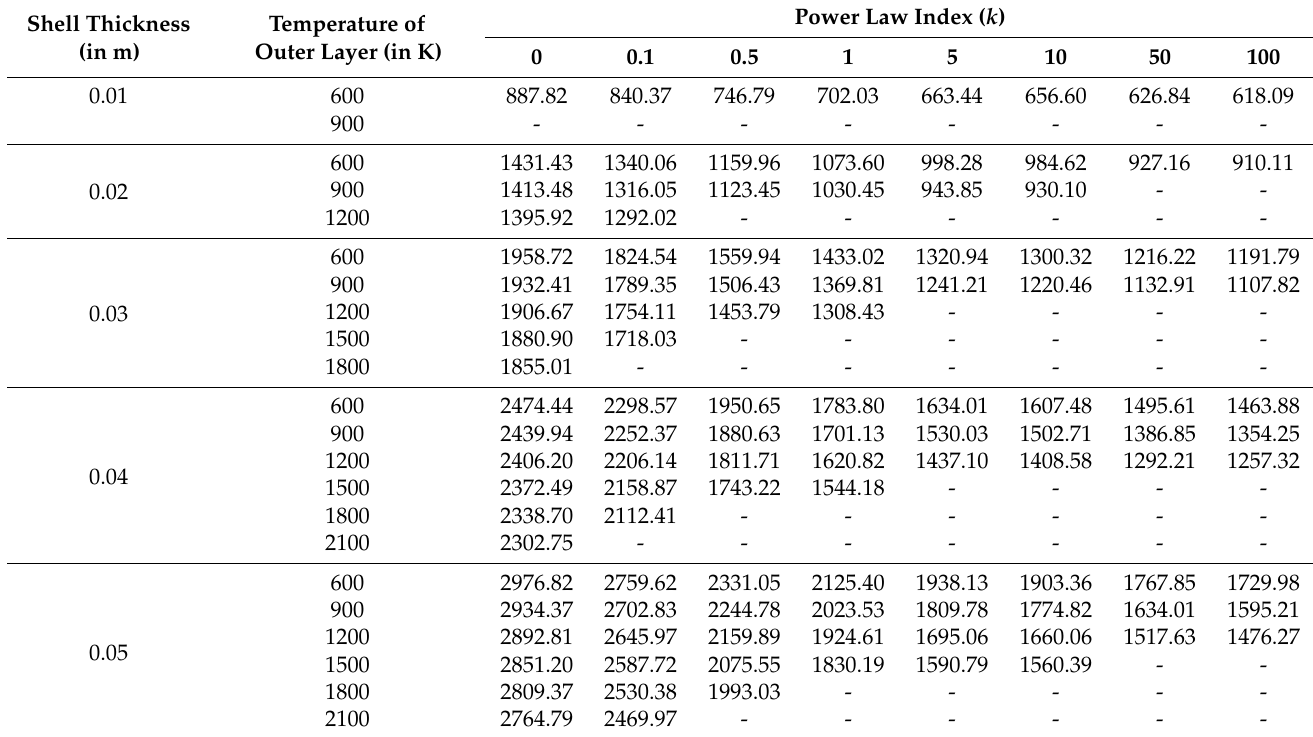
Table 13. Critical buckling temperature (in K) of a Ti-6Al-4V/silicon carbide FGM shell under linear temperature rise for various shell thicknesses in re-entry vehicle nose